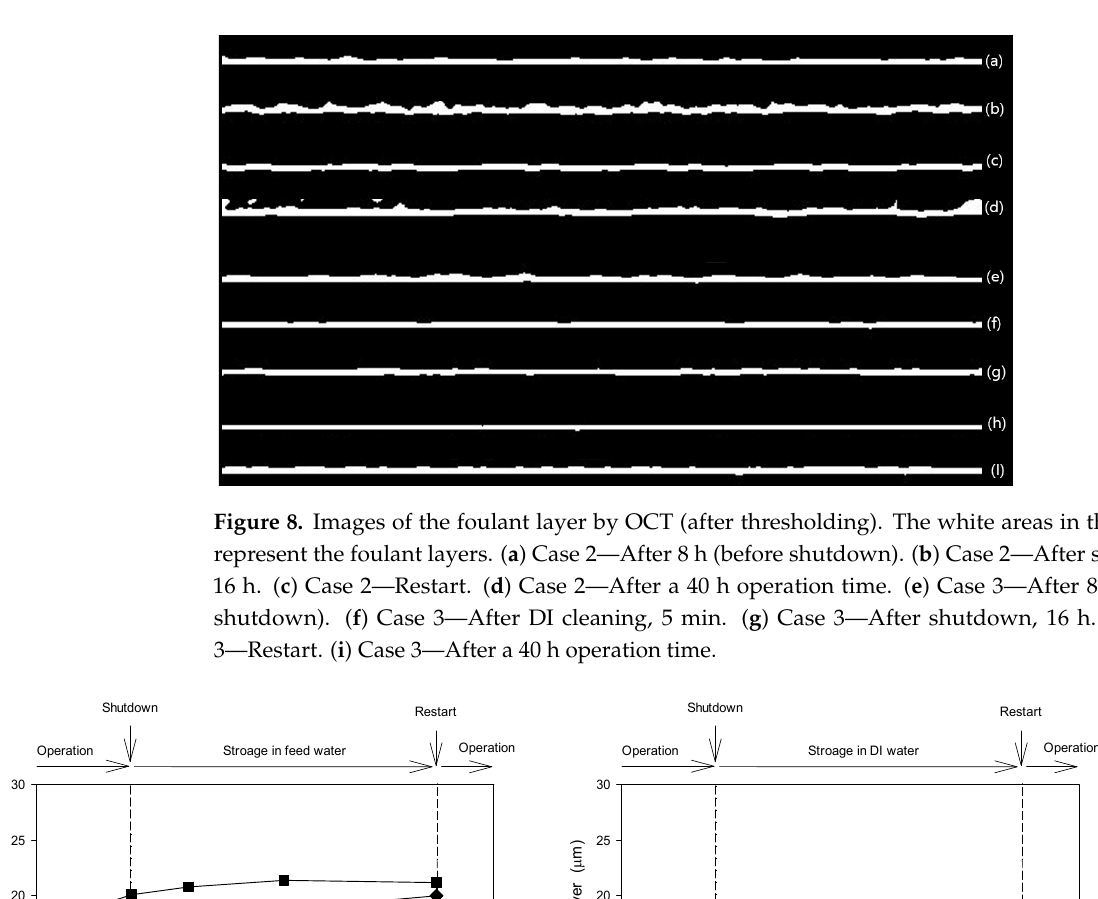
Figure 10. Proposed mechanism for fl ux enhancement and foulant removal by intermi tt ent operation.